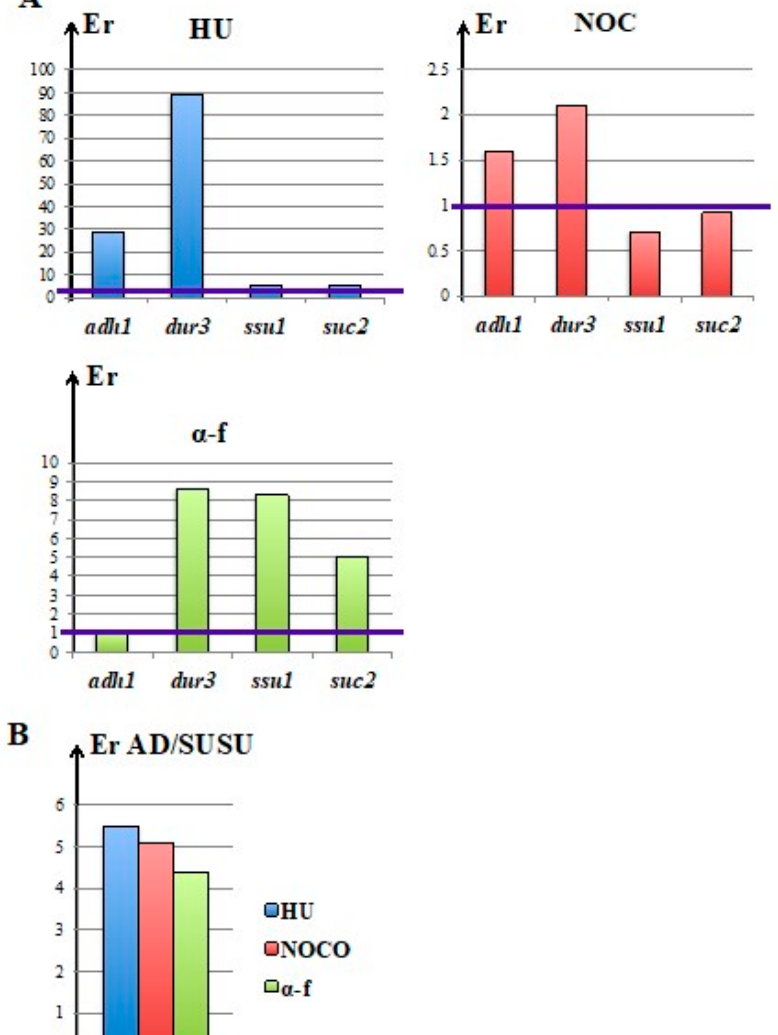
Figure 1. Transformability efficiency. ( A ) Relative efficiency of transformability (Er, see M & M for the mathematical calculation) with four different SSI DNA cassettes homologous to adh1 , dur3 , ssu1 and suc2 loci when yeast cells have been blocked with HU (blue), NOC (red) or α -f (green). The violet line represents the efficiency of transformability of an asynchronous population given a value of 1. In the case of α -f-blocked cells, the strain San1VT Δ MAT has been used as a wild type strain and reference strain for transformations in asynchronous conditions. ( B ) Comparison between the efficiency of transformability between the AD and the SUSU translocation cassettes in cells blocked with HU (blue), NOC (red) or α -f (green) . All the raw data used to create the Figure are listed in